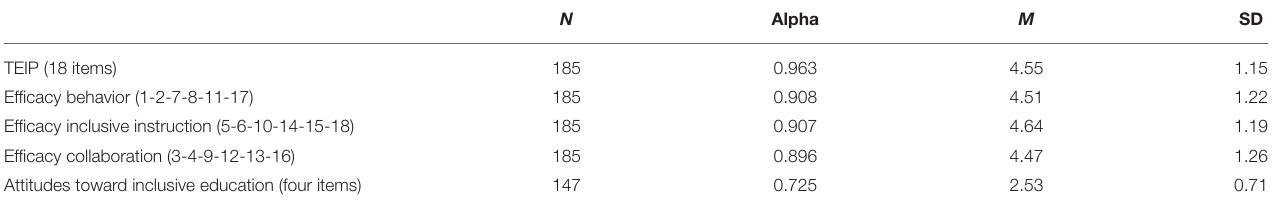
TABLE 1 | Means (M), standard deviations (SD), and reliability (Cronbach’s alpha coefficients) of the TEIP and its three subscales, as well as the attitudes scale.